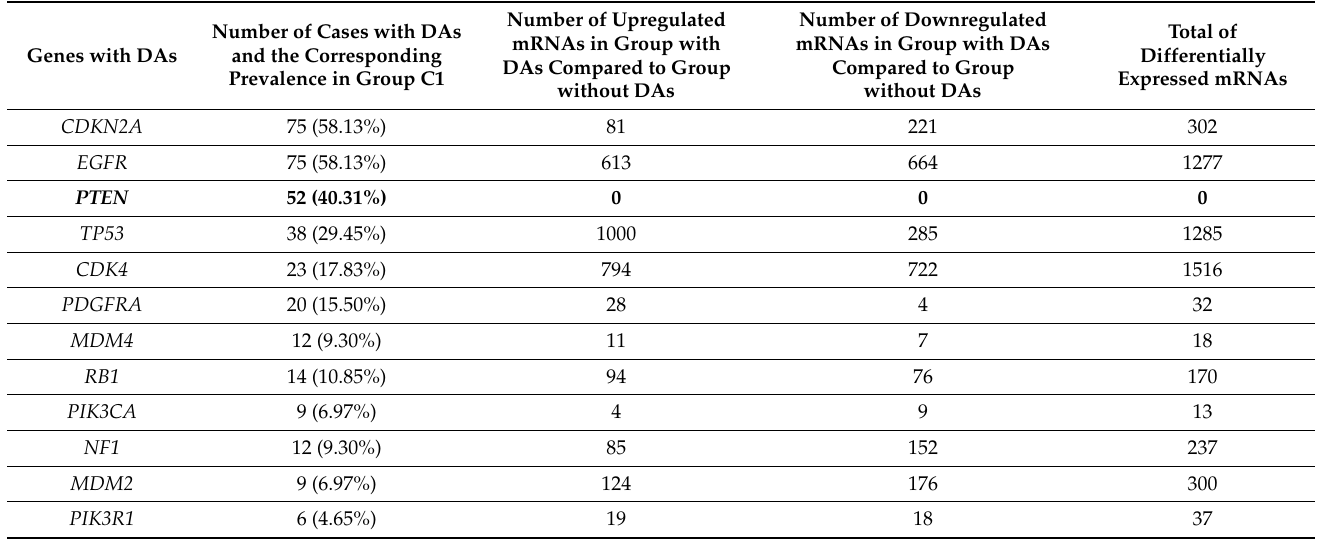
Table 2. The prevalence of cases with driver alterations in 12 common driver genes along with their associated counts of differentially expressed mRNAs (upregulated, downregulated and total counts). The analyses were performed on the C1 group.